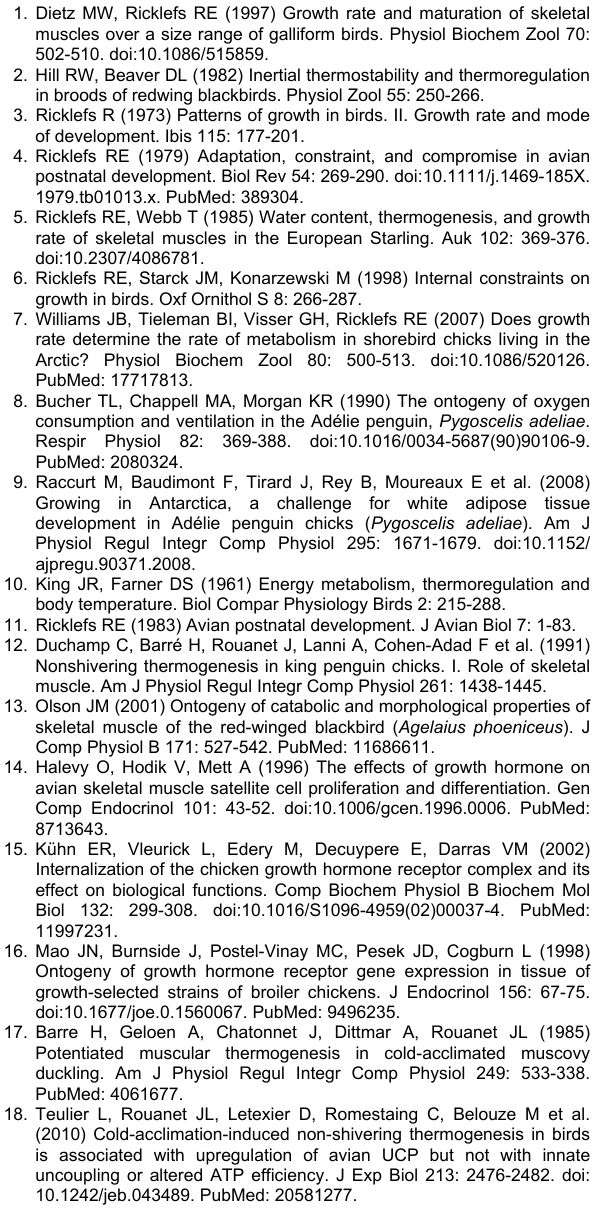
receptor (GHR – Panel A) and avian uncoupling protein (avUCP – Panel B) in pectoralis muscle from 1, 7, 15, 30 and 60-day- old Adélie chicks. The relative expression of each gene was expressed as a ratio to the 18S rRNA level. N = 6 per group. Bars correspond to means ± S.E.M. Bars with different letters are significantly different at